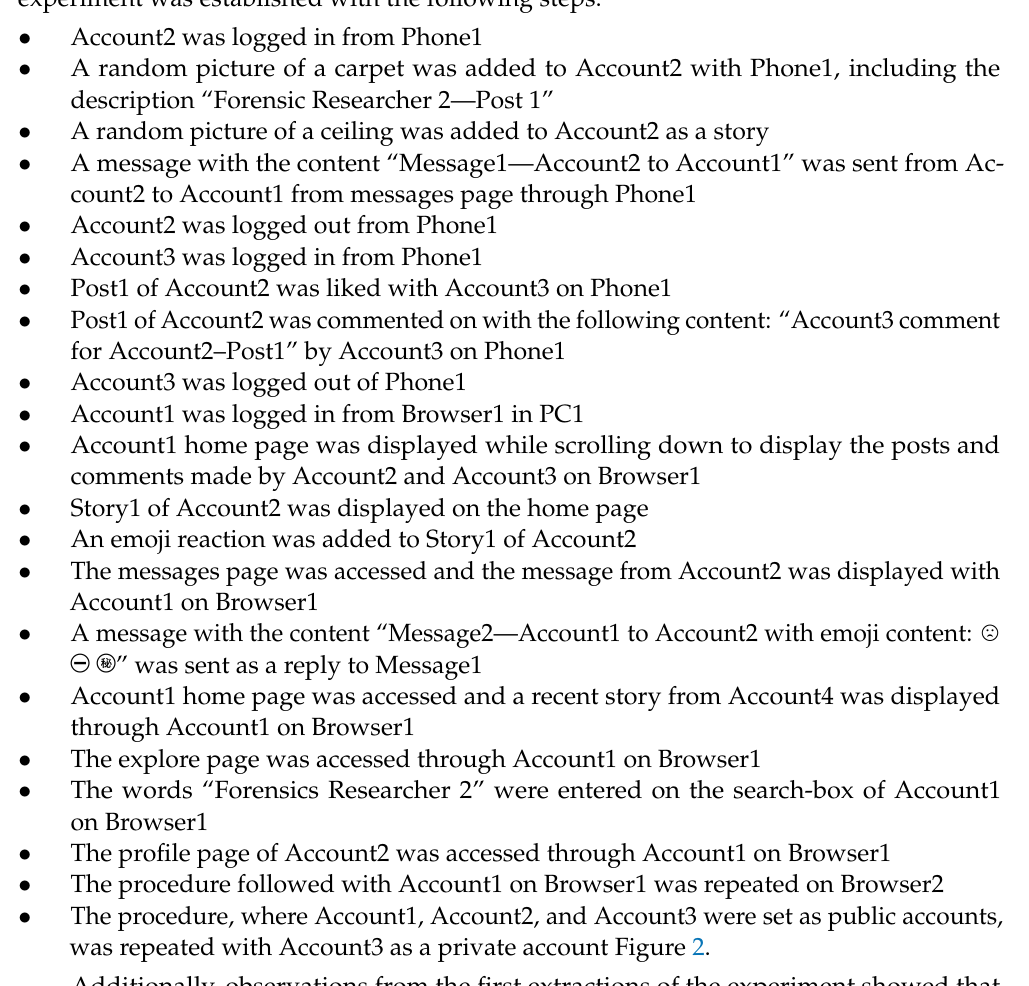
Table 12. Artifacts Found in stories.feedTray Record.